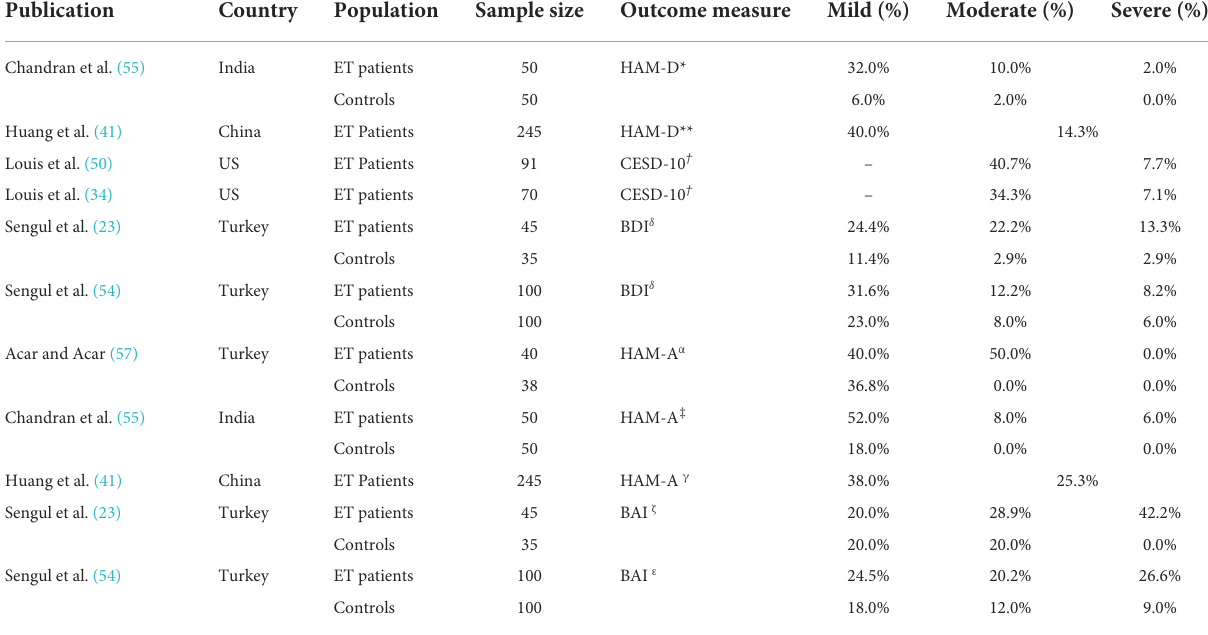
TABLE 2 Prevalence of varying severity of depression and